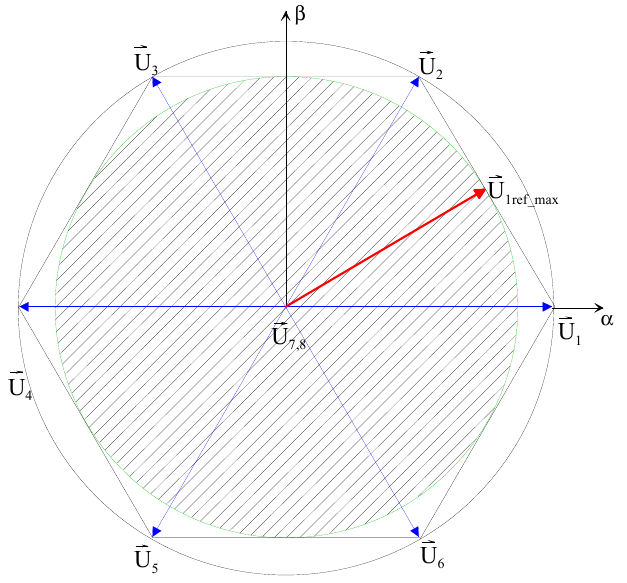
Figure 9. Space phasors of two-level voltage-source inverter (VSI) [6].